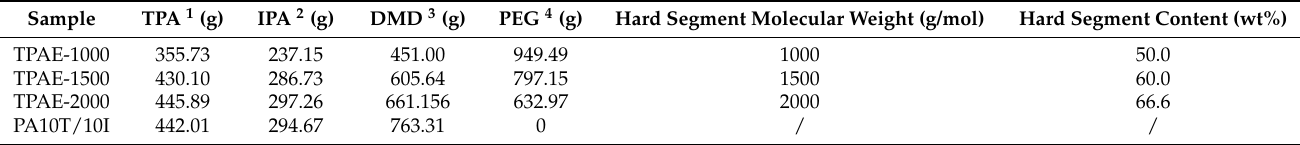
Table 1. Feeding mass of ingredients for preparation thermoplastic polyamide elastomers (TPAEs) and PA10T/10I.